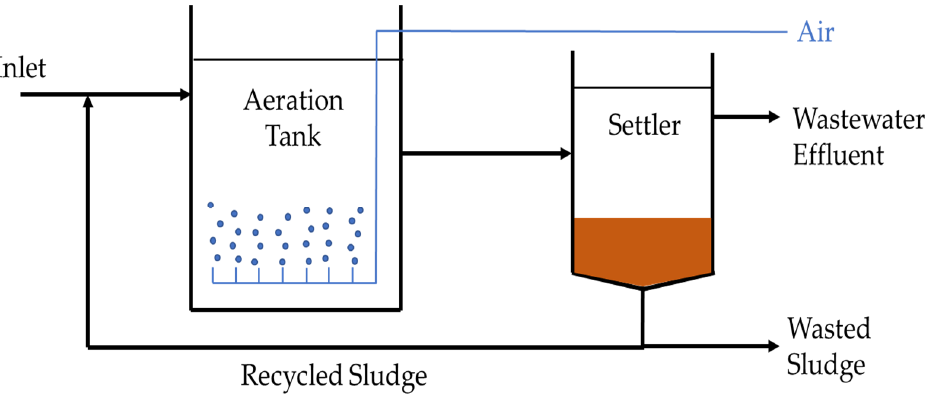
Figure 5. Schematic of the activated sludge system.